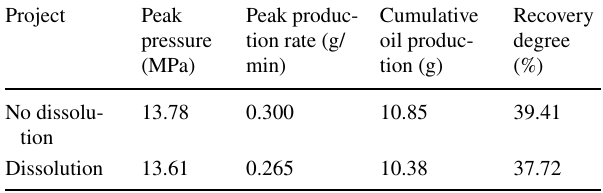
2 -flooding process